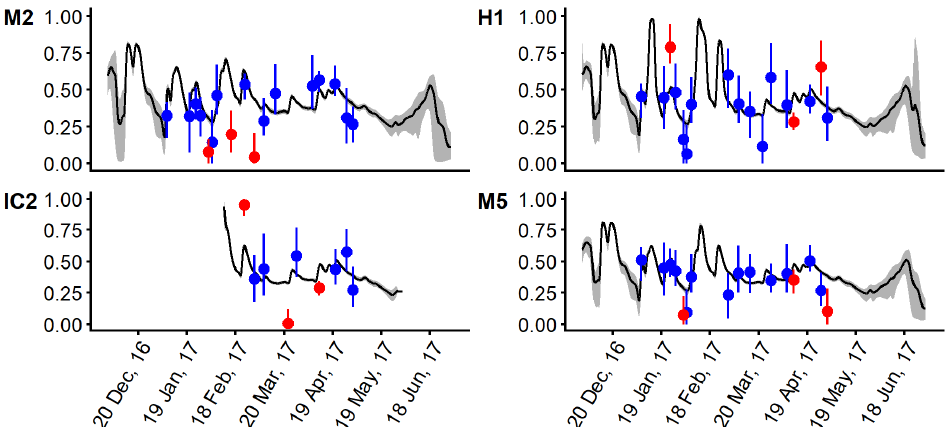
Figure 8. Time series at four locations showing the modeled Cosumnes and Other concentrations with the tidal average (black line) and tidal envelope (grey ribbon). The isotope mixing model values are shown as points with the isotope instrument 95% confidence intervals extending from the mixing model value. Blue points are those whose isotopic confidence intervals overlap with the modeled tidal envelope, while red points do not.